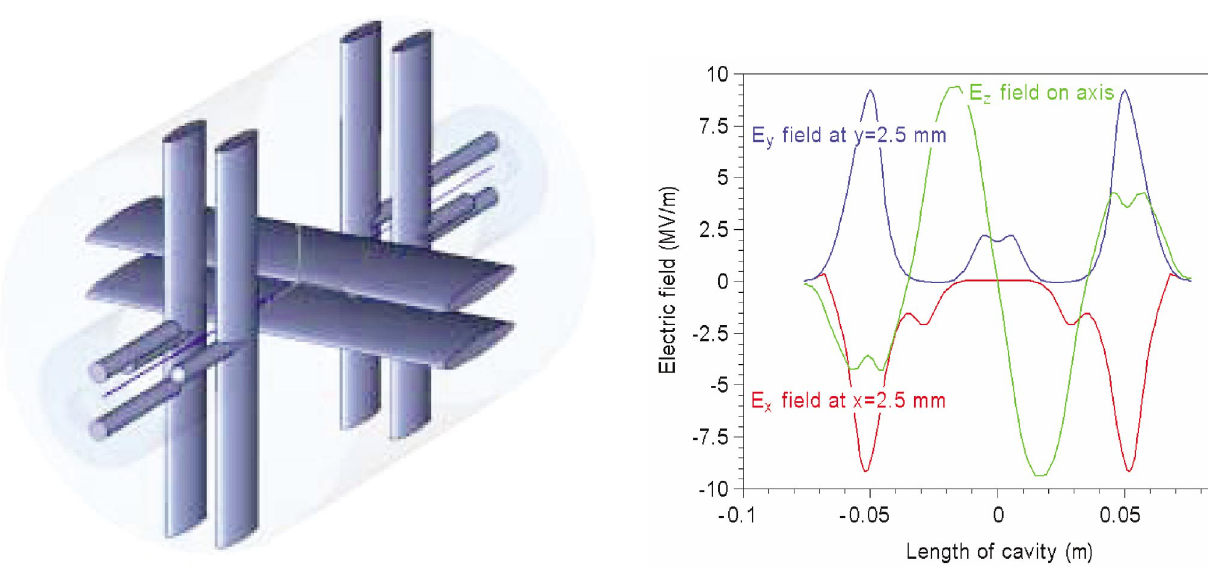
FIG. 9. (Color) The slot-finger resonator in 3D. FIG. 10. (Color) Field distribution in the slot-finger